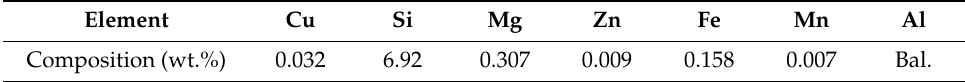
Figure 2. Crack growth behavior of AC4CH fatigue samples. Each curve is shifted so that the fatigue cycle at the crack length of 2.5 mm is the origin of the horizontal axis. Laser peening without coating (LPwC) was applied, and fatigue loading continued. Computed tomography (CT) was performed after an additional 10 5 loading cycles at SPring-8. 2.2. Experimental Setup for SR-based CT CT imaging of fatigue cracks used beamline BL19B2 of SPring-8 as shown in Figure 3. The X-ray energy was adjusted to 28 keV using a double-crystal monochromator. The sample was placed about 110 m distant from the X-ray source (a bending magnet). The X-ray area detector (a cooled CCD camera) was positioned 0.8 m behind the sample to allow a phase-contrast effect. During sample rotation, projected data of 1,024 × 1,024 pixels were recorded every 0.5° from 0 to 180°. The detector pixel size corresponded to about 6 µm, given its optical magnification of a relay lens after an X-ray- to-visible converter. Each slice was reconstructed using a filtered-back projection algorithm. The distance between the X-ray source and the sample was determined by considering the blur of the image and the resolution of the detector [48]. The X-ray source size was 0.3 mm wide and 0.1 mm high. Since the magnification of the experimental system (D 2 /D 1 ) was 7.3 × 10 − 3 , the horizontal blur was 2.2 µm and the vertical was 0.7 µm, which are sufficiently small compared to the resolution of the X-ray area detector of about 6 µm.